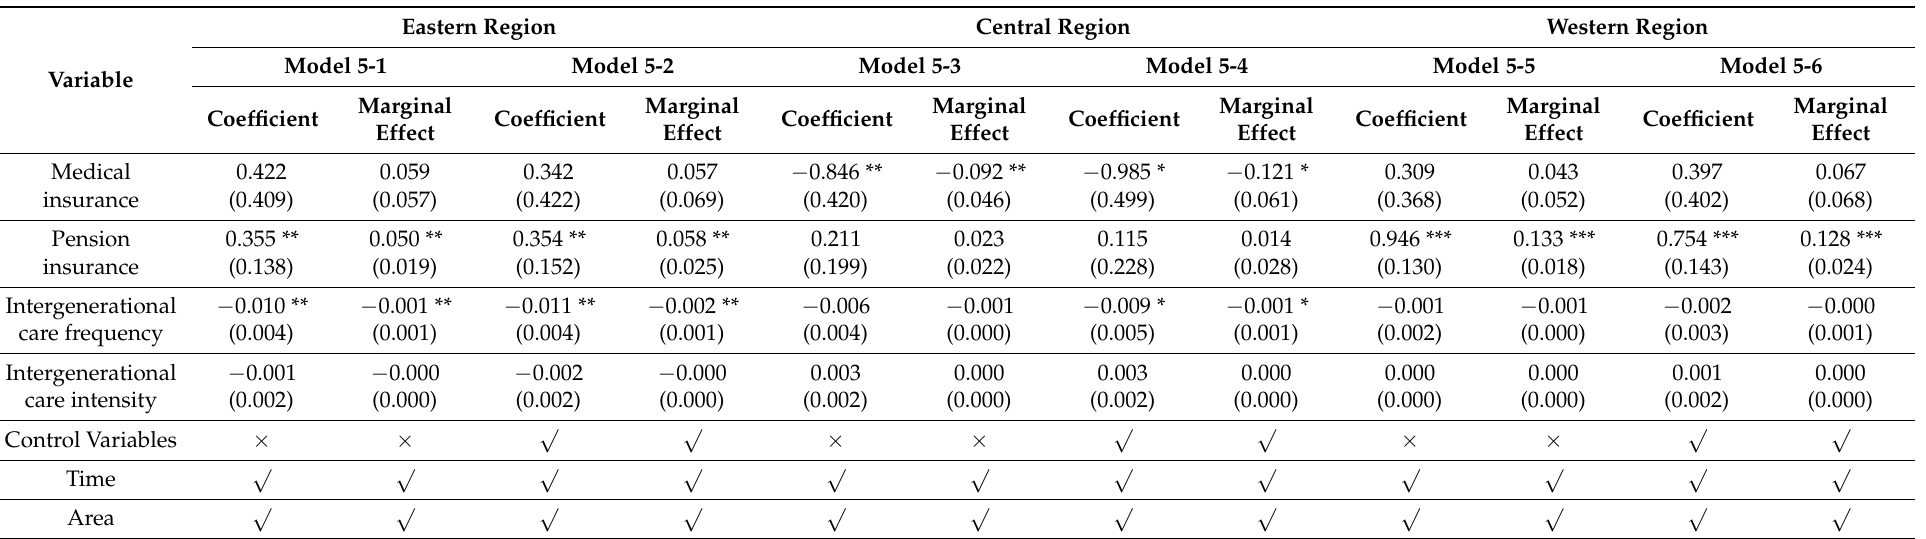
Table 5. Results of the sub-regional tests of the sample